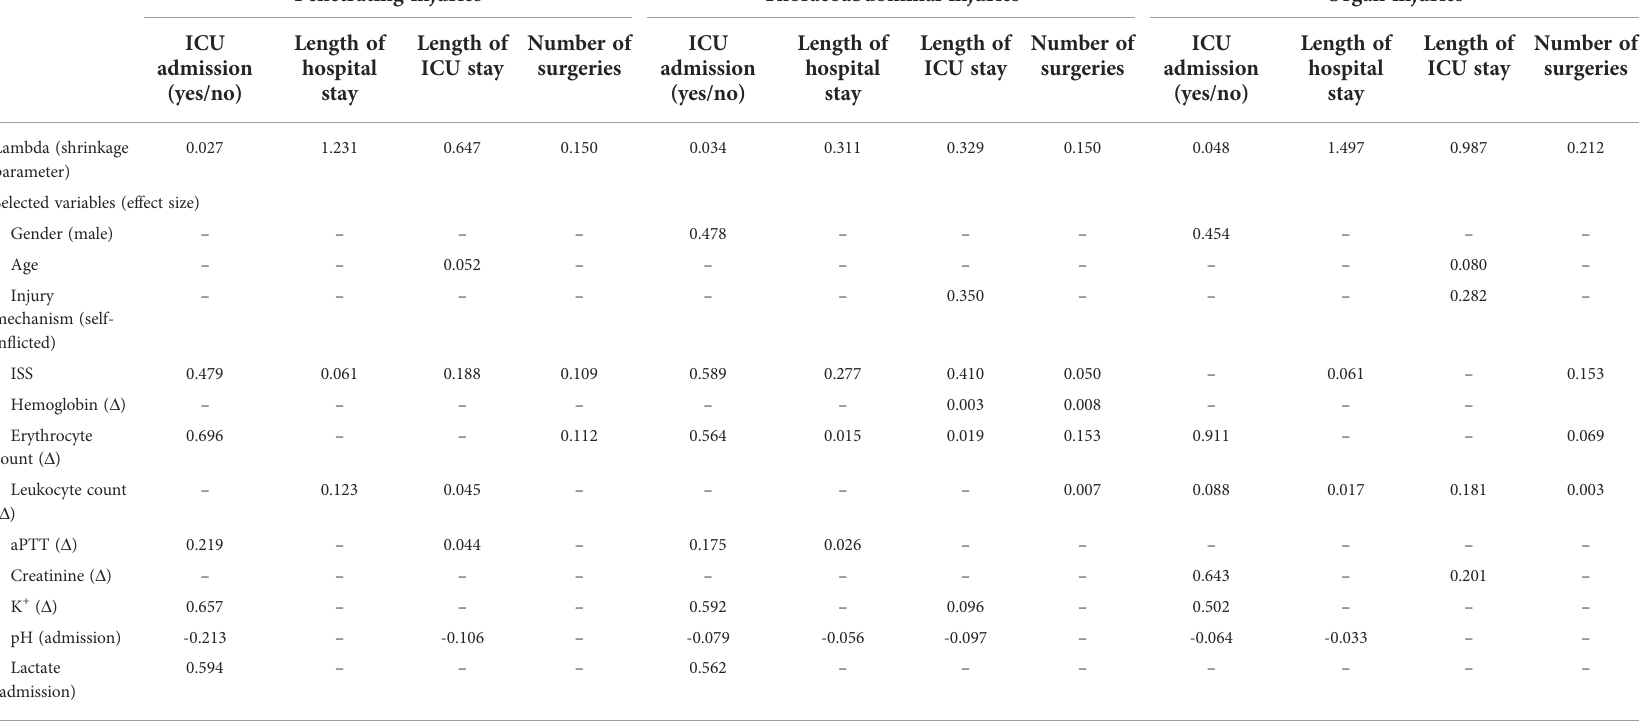
TABLE 2 LASSO-selected predictive variables with corresponding coef fi cients (n =